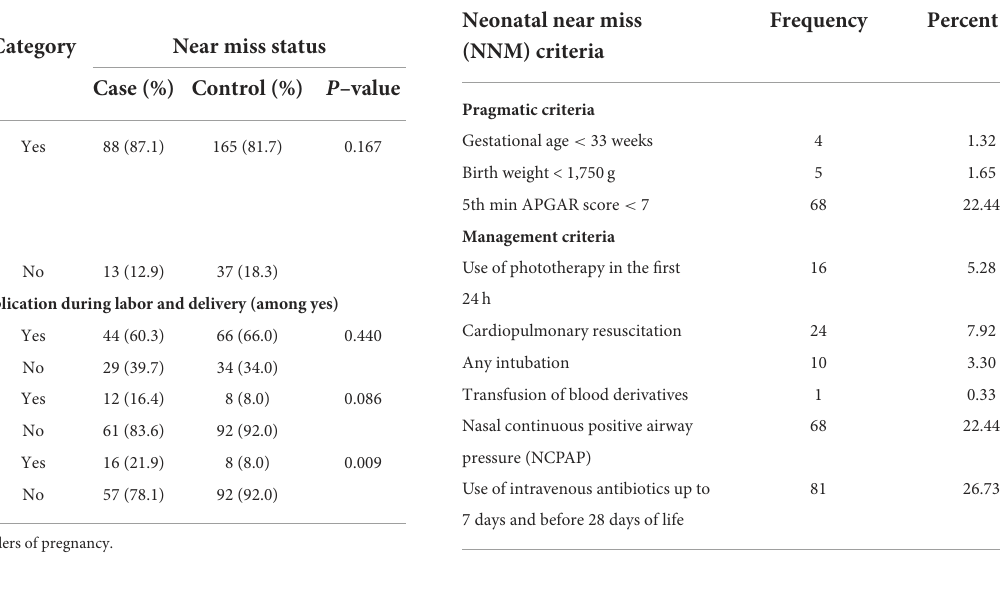
TABLE 6 Distribution of NNM conditions among neonates delivered in public hospitals of Ilu Abba Bor Zone, 2020 ( n = 303).